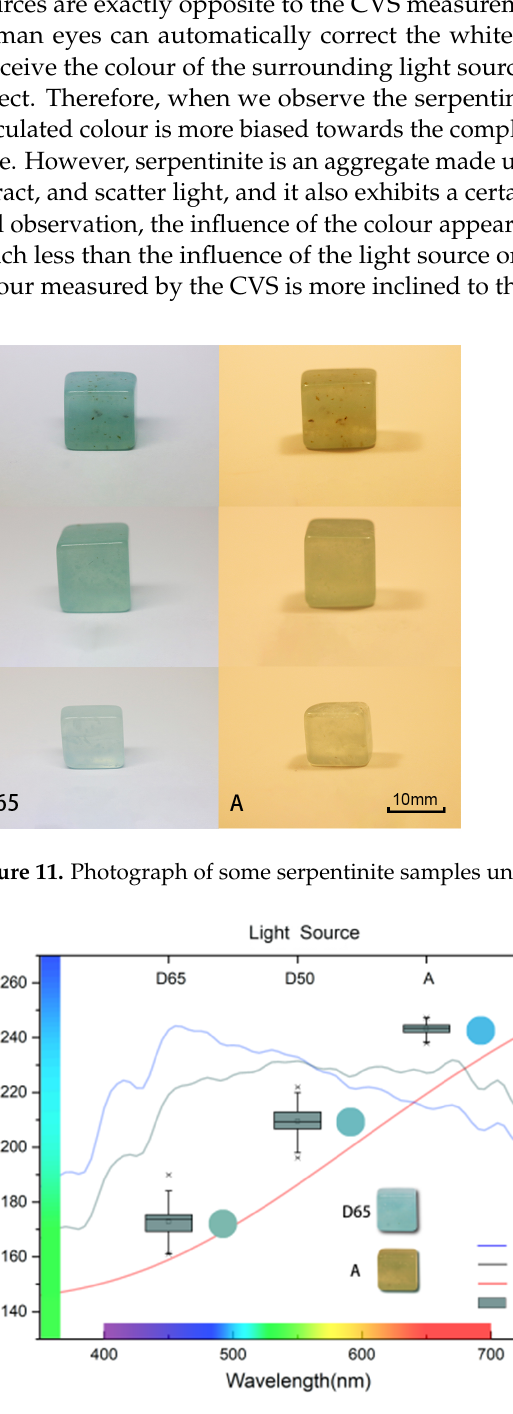
Figure 12. Predicted hue angle distribution under three light sources D65, D50, and A, based on the CAM16-UCS. The change of hue angle is opposite to the CVS measurement result, shifting to the blue rather than yellow area as the colour temperature of the light source decreases.